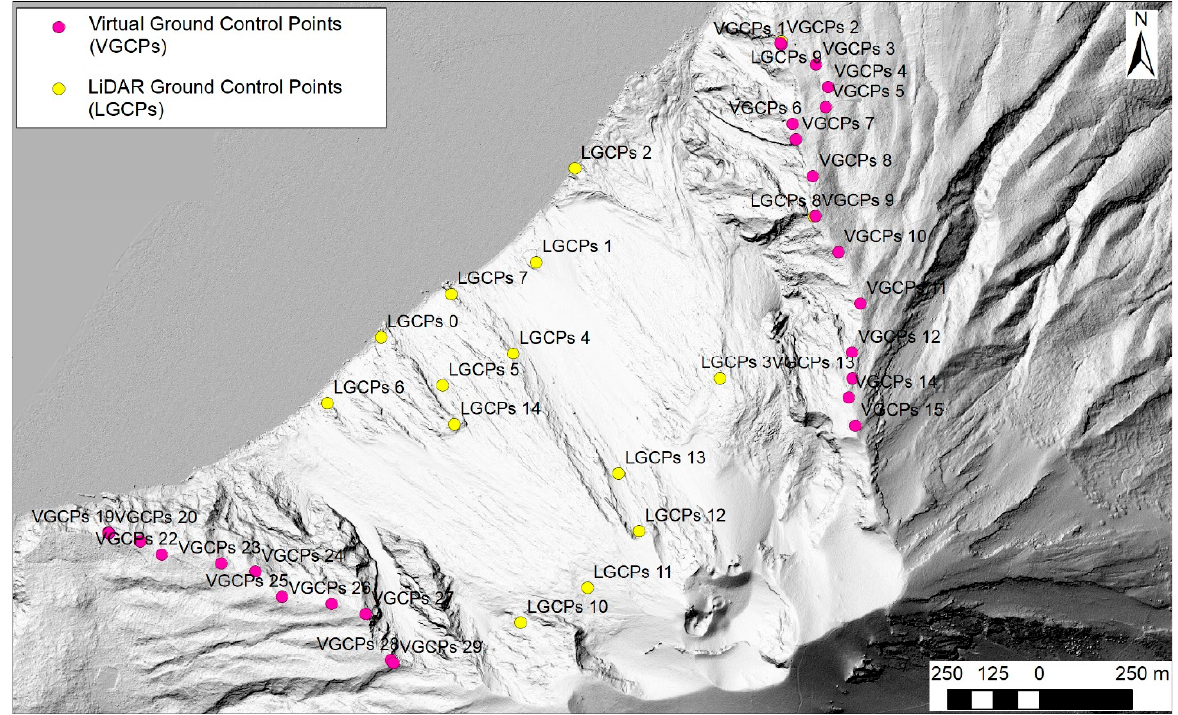
Figure 3. Position of Virtual Ground Control Points (VGCPs) derived from the Stromboli 6 dataset and Lidar Ground Control Points (LGCPs) obtained from the LiDAR survey carried out in 2012.